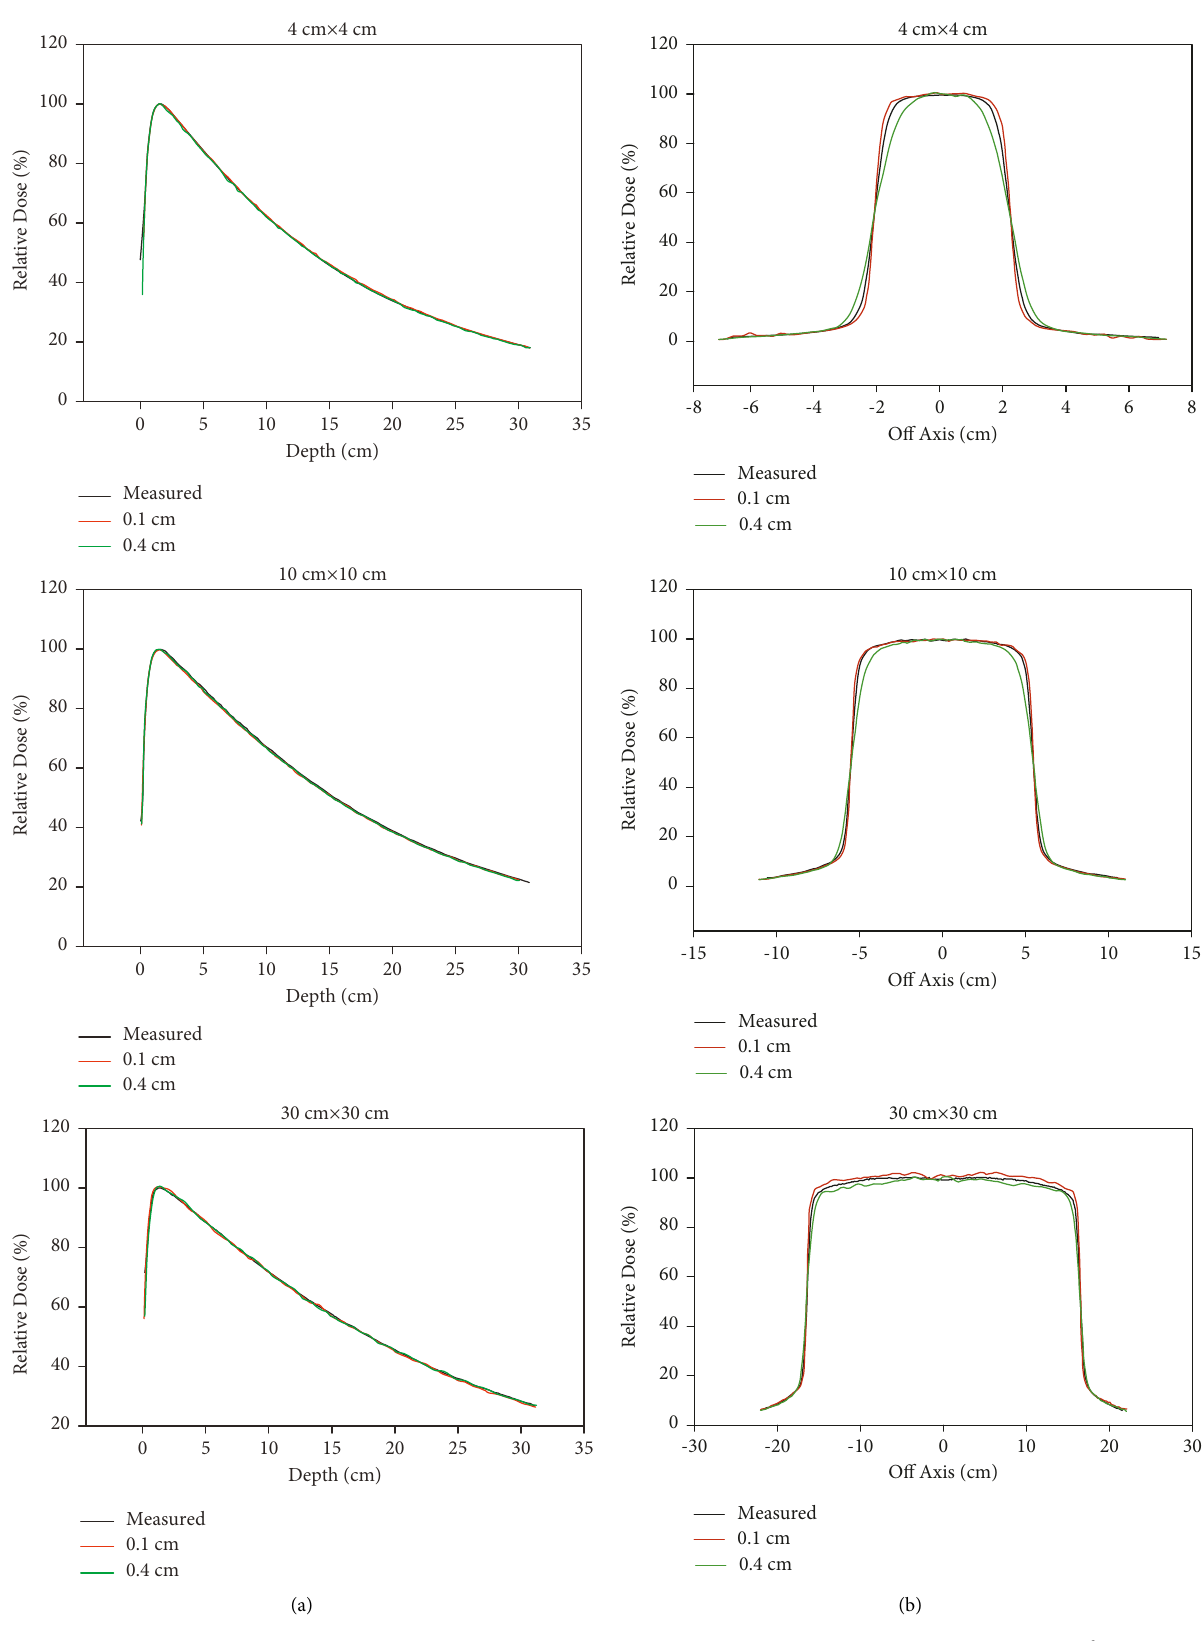
Figure 4: (a) The influence of the radial intensity distribution of incident electrons on PDDs for 4 × 4, 10 × 10, 30 × 30cm 2 fields. (b) The influence of radial intensity distribution of incident electron on OARs for 4 × 4, 10 × 10, 30 × 30cm 2 fields at 10cm depth. The red curve represents the dose curve when the radial intensity FWHM is 0.1 cm, the green curve represents the dose curve when the radial intensity FWHM is 0.4cm, and the black curve represents the measured dose